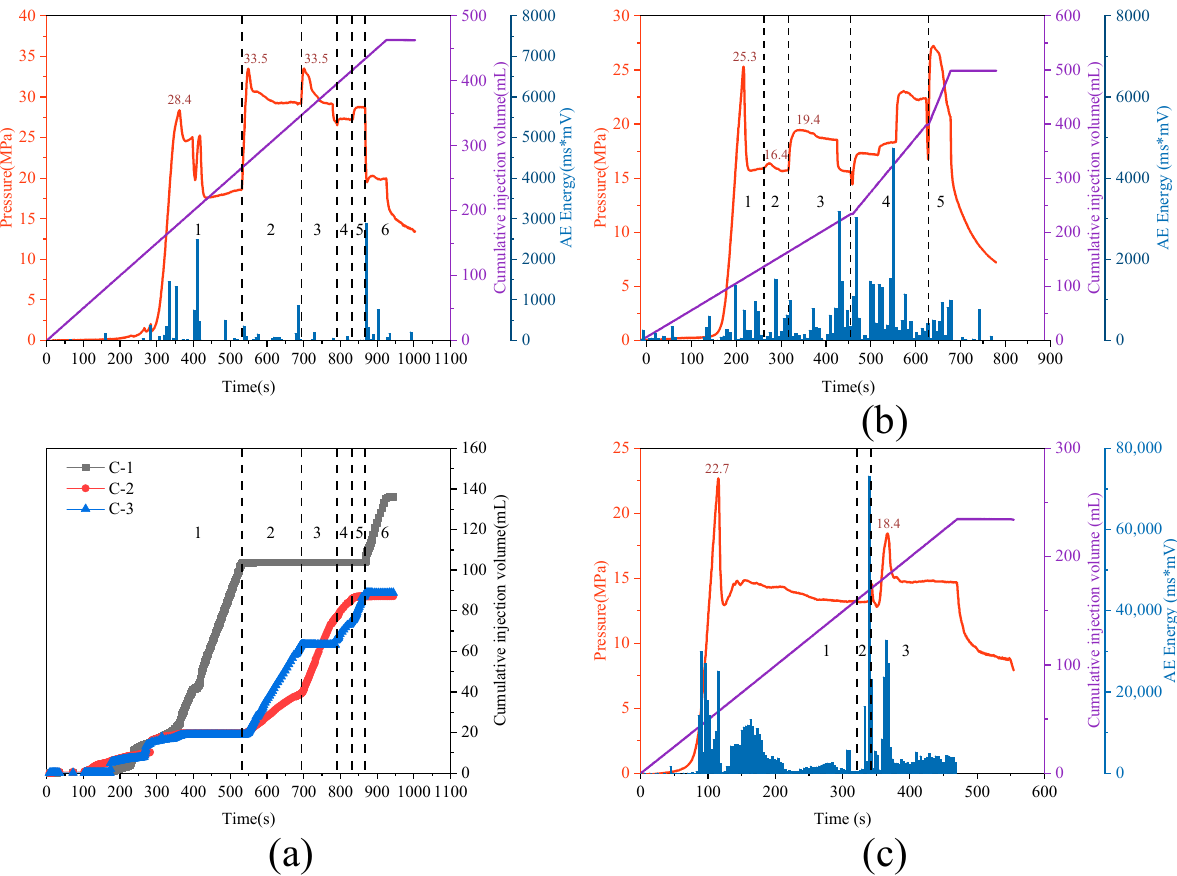
Figure 6. Pressure, cumulative injection volume, and acoustic emission energy curves: ( a ) Test 1 (top: pressure curve; bottom: cumulative injection volume of each channel); ( b ) Test 2; ( c ) Test 6.